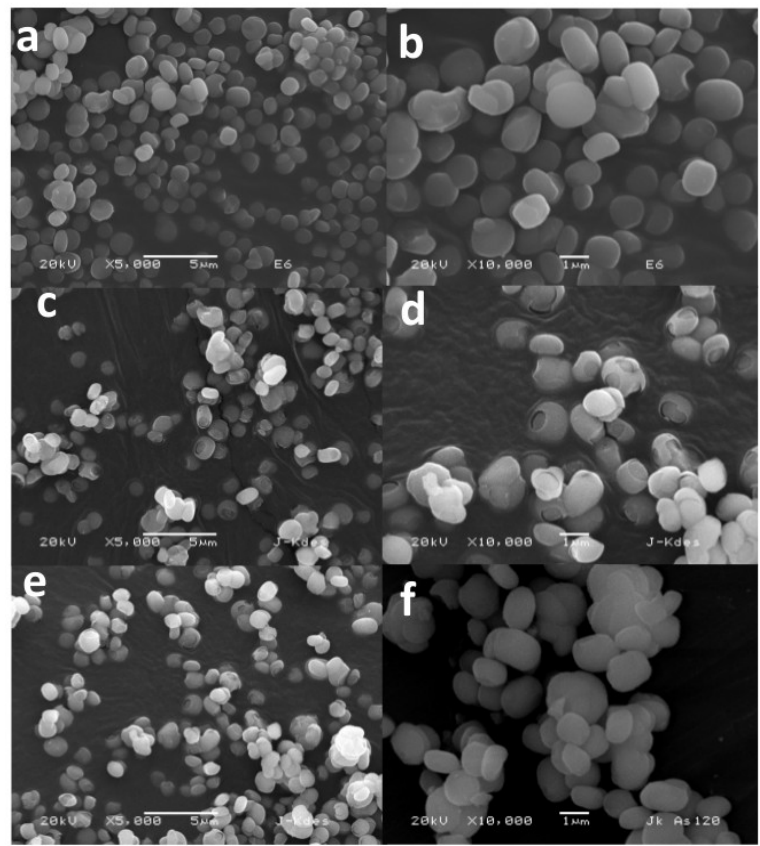
Figure 6. SEM (SE) images of: ( a , b ) synthesized potassium jarosite; ( c , d ) decomposed potassium jarosite; and ( e , f ) potassium jarosite with As(V) and recrystallized. Left and right column images are under magnifications of 5000× and 10,000×, respectively .